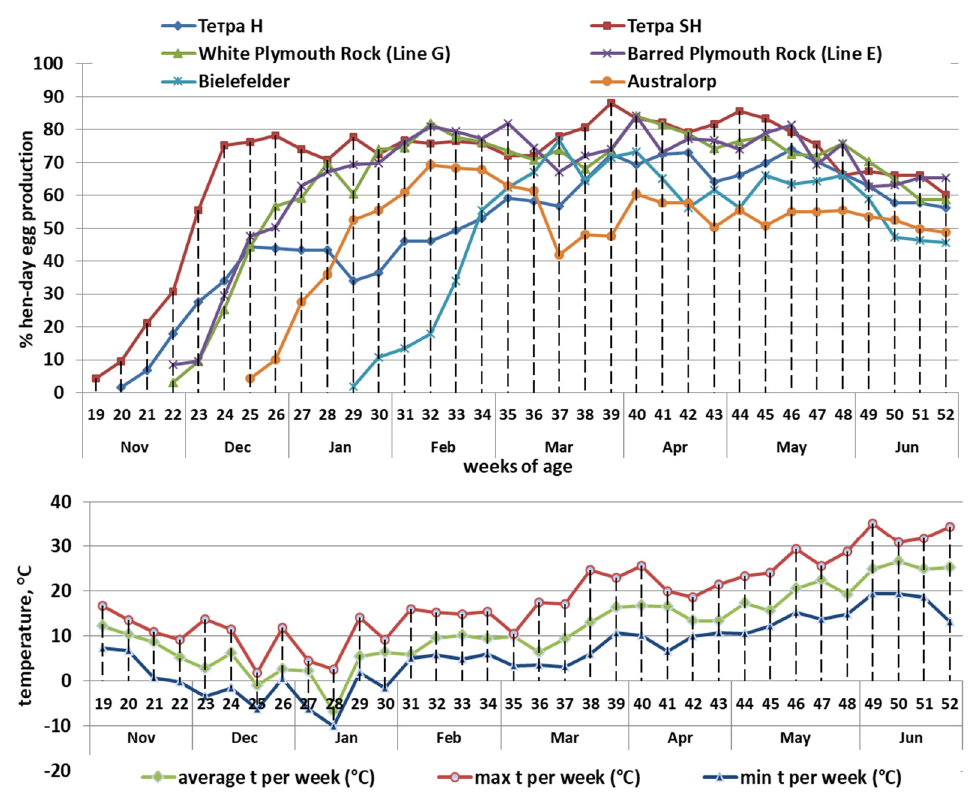
◦ C) in second experimental